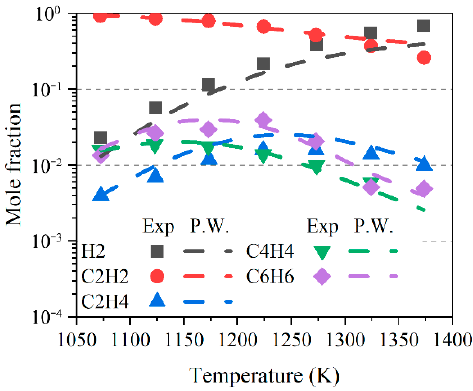
Figure 5. Numerical simulation of the prediction results of acetylene pyrolysis species concentrations (light molecules) and data with experimental results. P.W.—present work. Exp—Norinaga et al. [37].